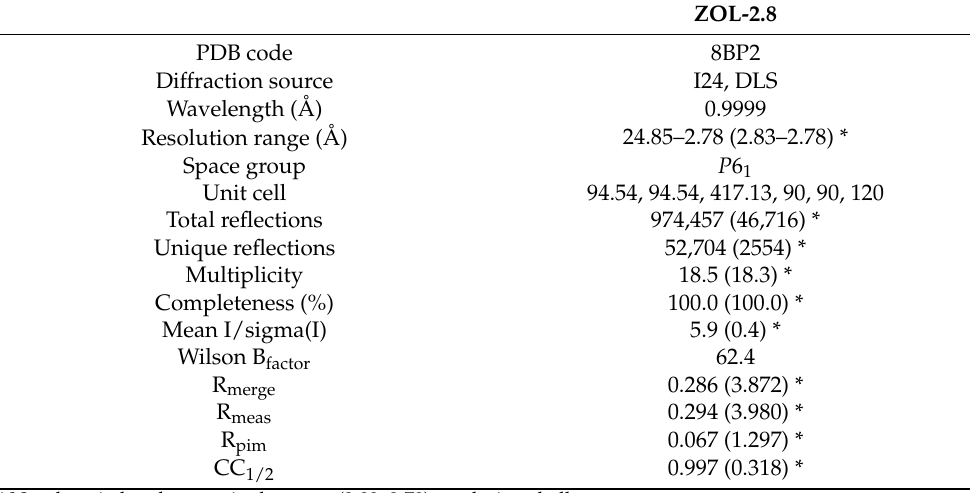
Table 2. Data collection statistics.